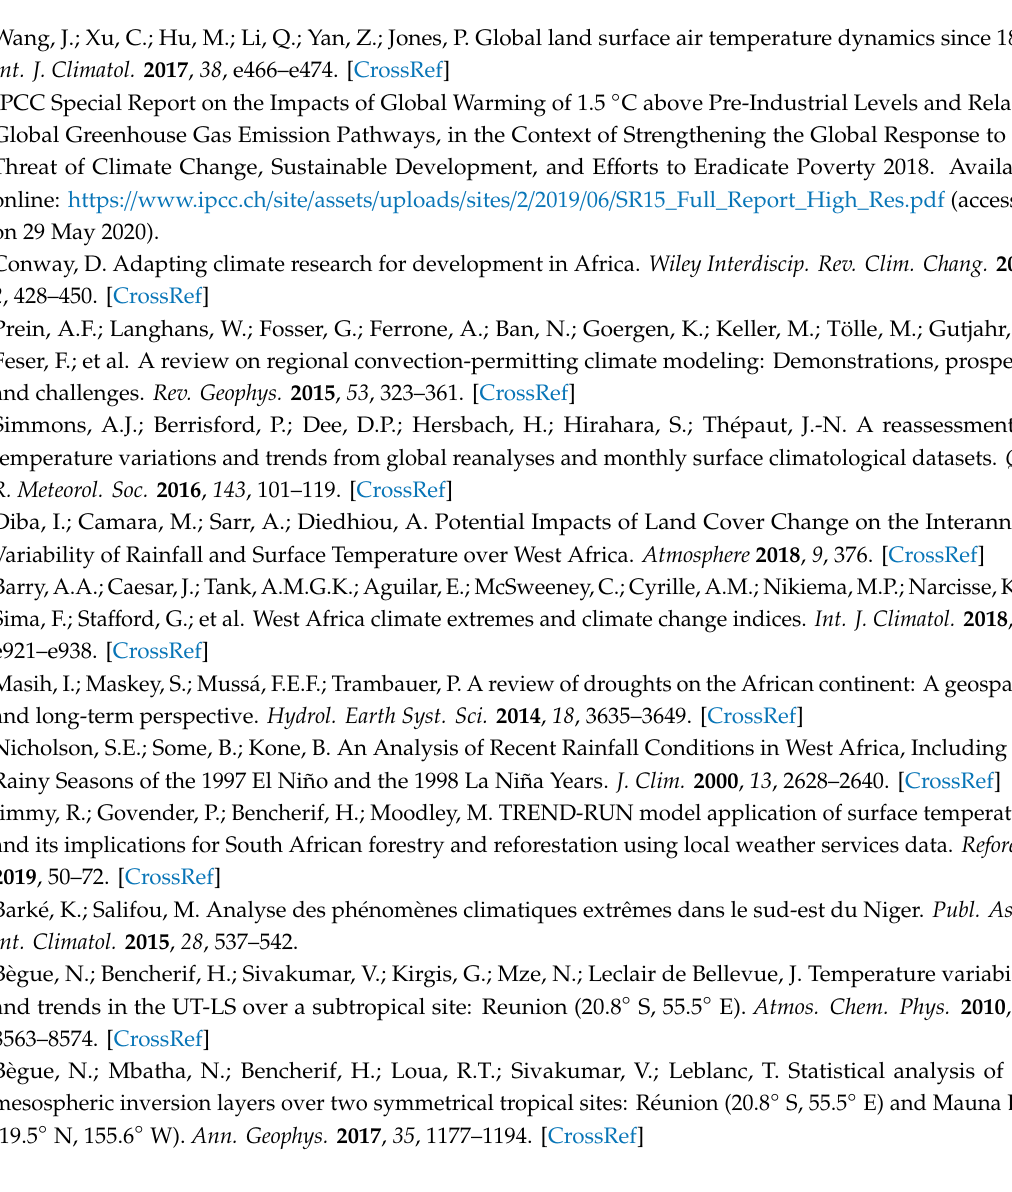
Figure A2. Spatial distribution of the temperature trend calculated by the Trend-Run ( a ) and MK ( b ).